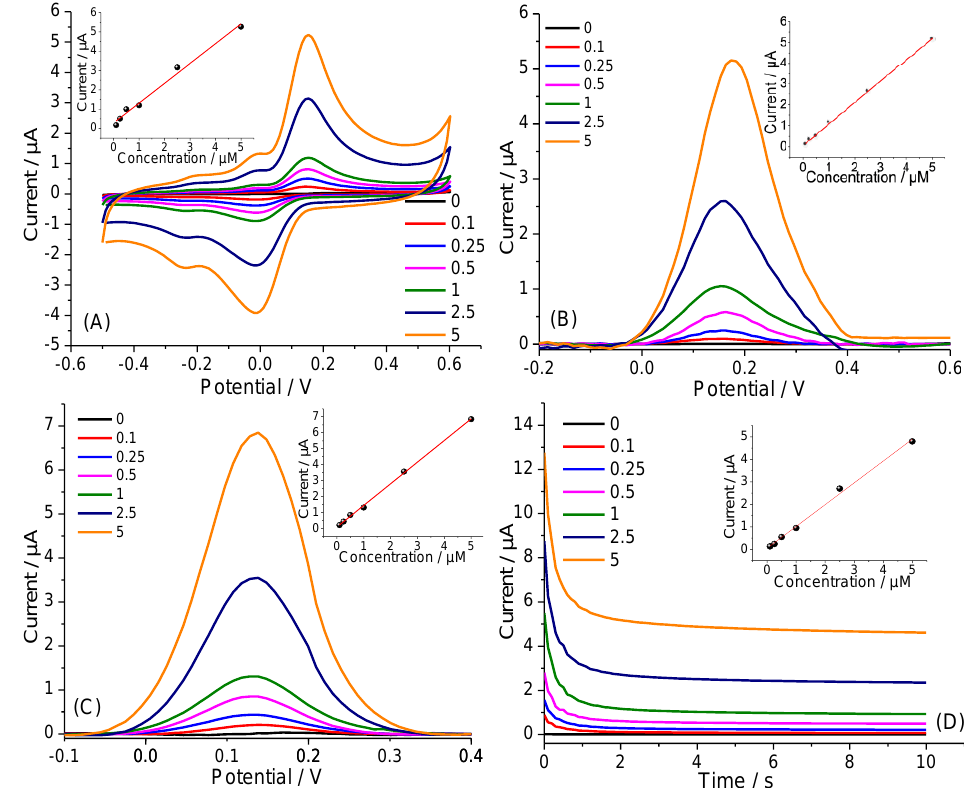
Figure 4. Electroanalytical performance of CTS sensing electrodes toward the detection of Clz in PBS buffer (in 10 mM, pH 7.4) with different concentrations: 0.1, 0.25, 0.5, 1.0, 2.5, and 5 µ Clz. ( A ) CV, ( B ) DPV, ( C ) square-wave voltammogram responses, and ( D ) amperometric responses. Insets show the corresponding calibration plots. Insets: concentration versus response plots.